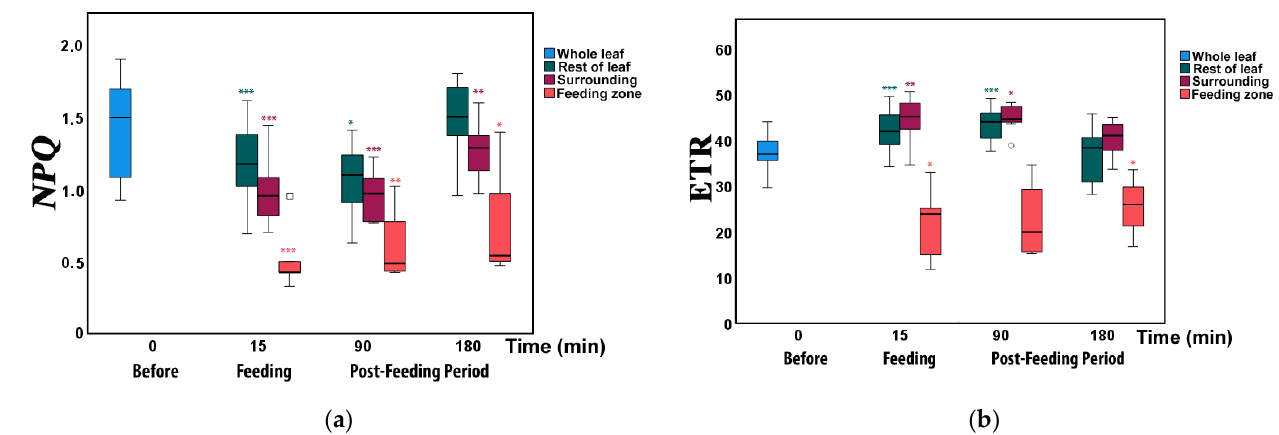
Figure 6. Changes in ( a ) non-photochemical quenching (NPQ) and ( b ) electron transport rate (ETR) in different zones of tomato leaflets before (0 min), immediately after (15 min), and post-feeding period, 90 and 180 min after insect feeding. Symbols, box plots, and significances are as in Figure 3.